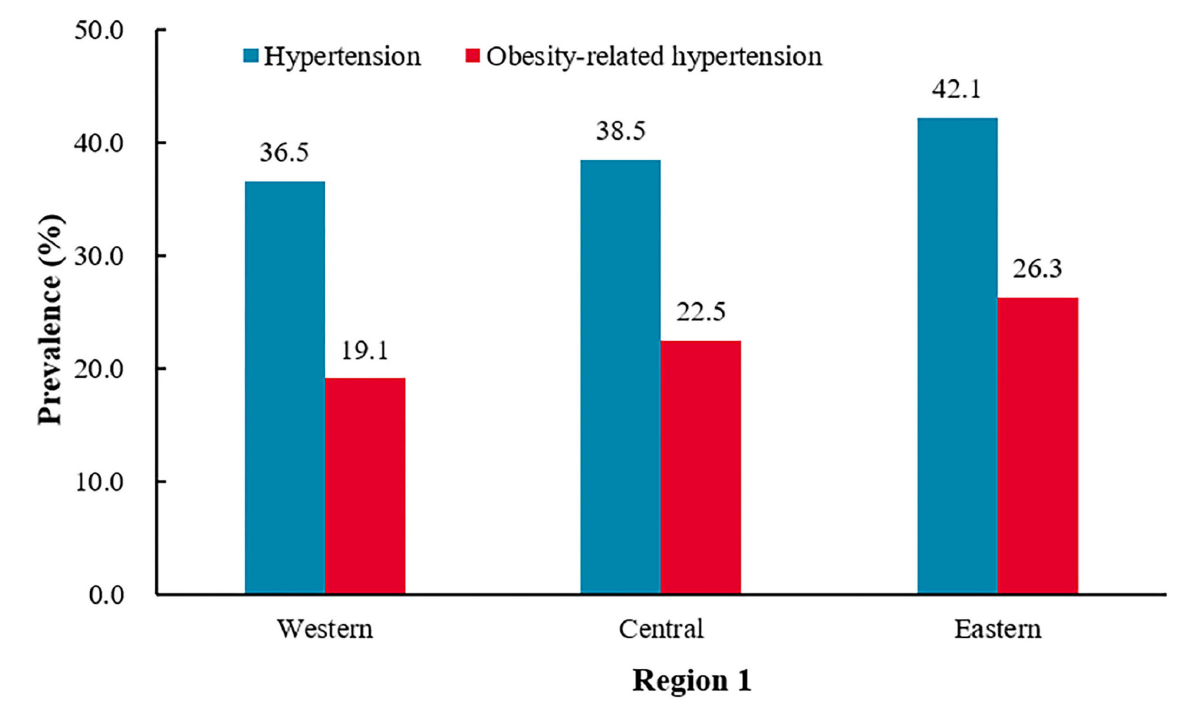
FIGURE4 The prevalence of hypertension and obesity-related hypertension among Western, Central, and Eastern provinces. † P < 0.0001 for the difference in the prevalence of hypertension between Western, Central, and Eastern provinces. ‡ P < 0.0001 for the difference in the prevalence of obesity-related hypertension between Western, Central, and Eastern